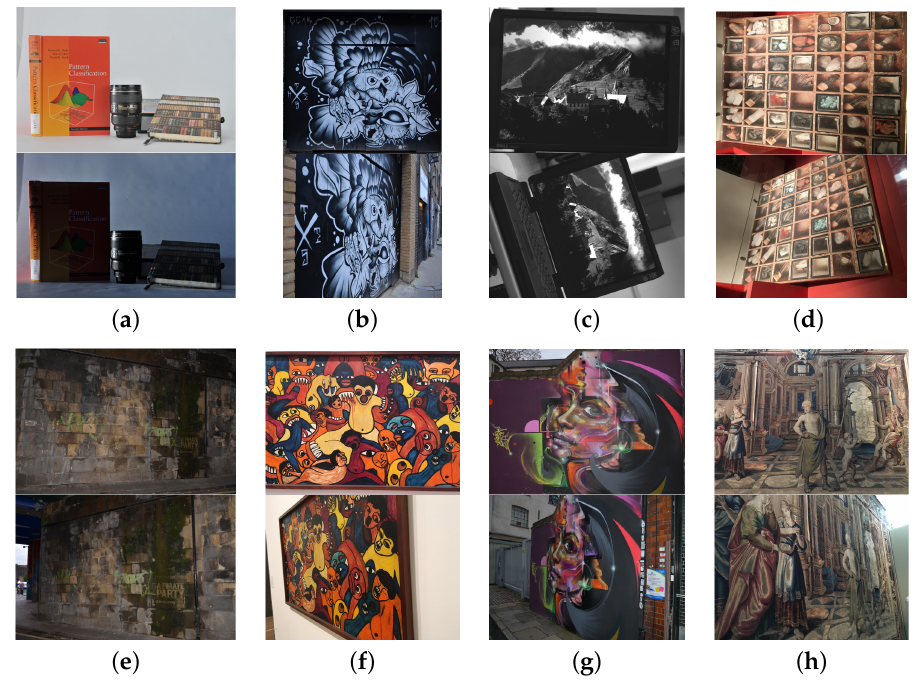
Figure 5. ( a – h ) The rigid dataset (close-range dataset